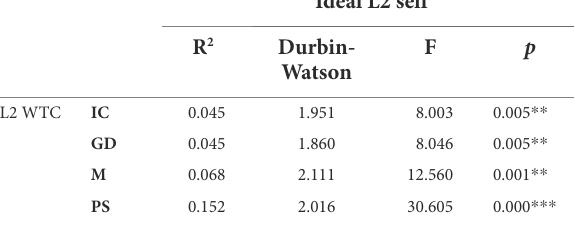
TABLE 2.2 Univariate regression analyses (Ideal L2 self as independent variable).